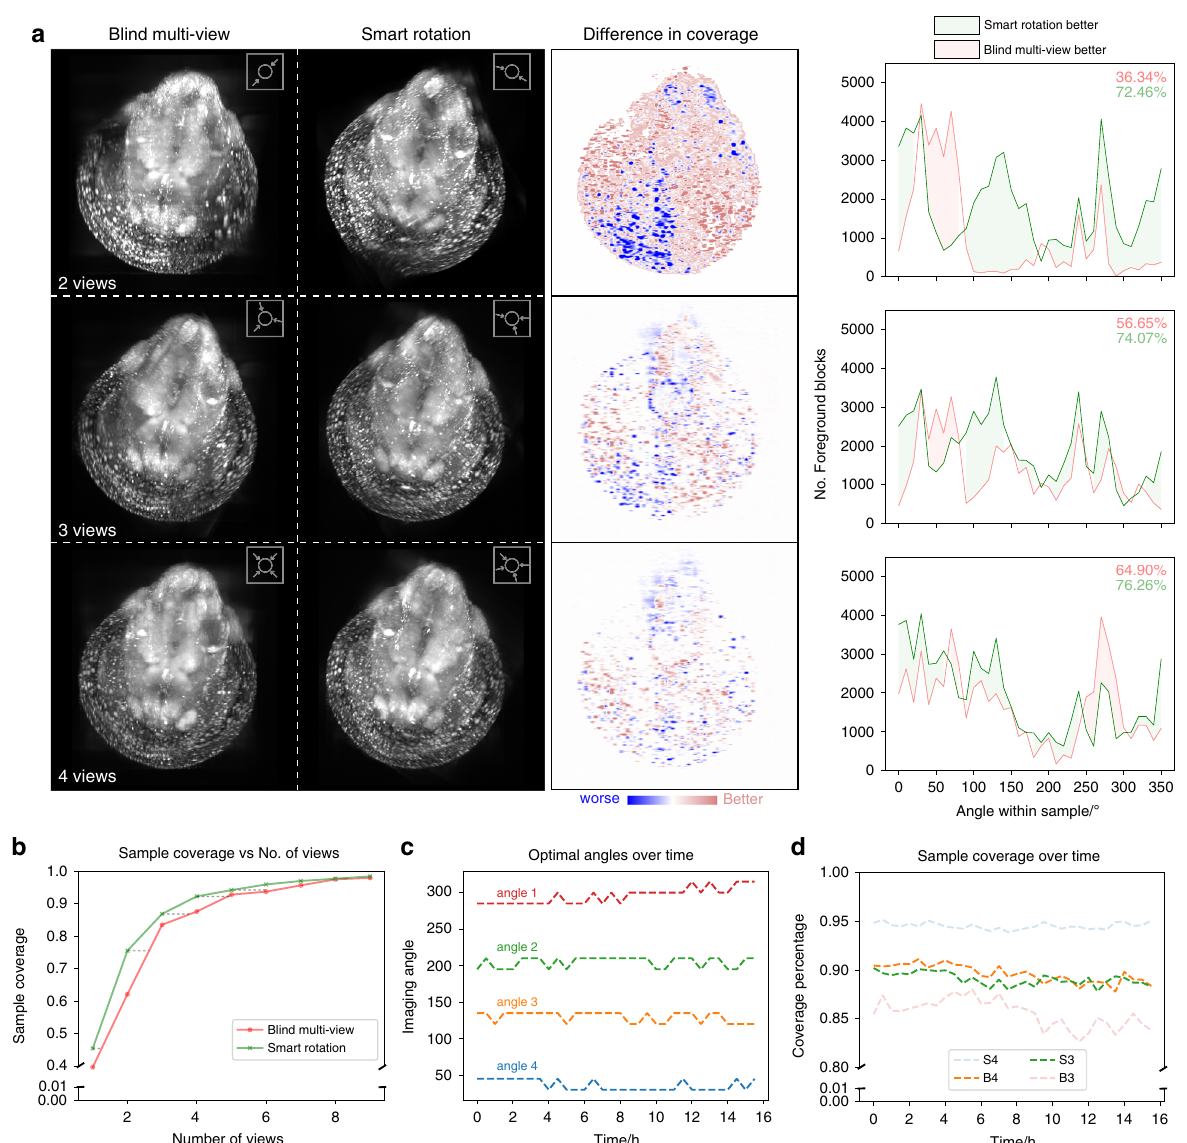
Fig. 5 Performance comparison between blind multi-view imaging and the smart rotation work fl ow. a Comparison between the fused images from a blind multi-view approach and our smart rotation work fl ow. The difference image is calculated as the difference in information content between the smart rotation generated image and the blind multi-view generated image. Number denotes relative image coverage. b Sample coverage measured as a percentage of the maximum possible against the number of views used. c Angles selected by the smart rotation evaluation during a 16 h time-lapse of a zebra fi sh embryo ( Tg(kdrl:GFP) ). d Sample coverage percentage comparison between the smart rotation work fl ows and blind multi-view work fl ow over the 16 h time-lapse. S denotes smart rotation work fl ow and B denotes blind multi-view work fl ow and number denotes and number of view